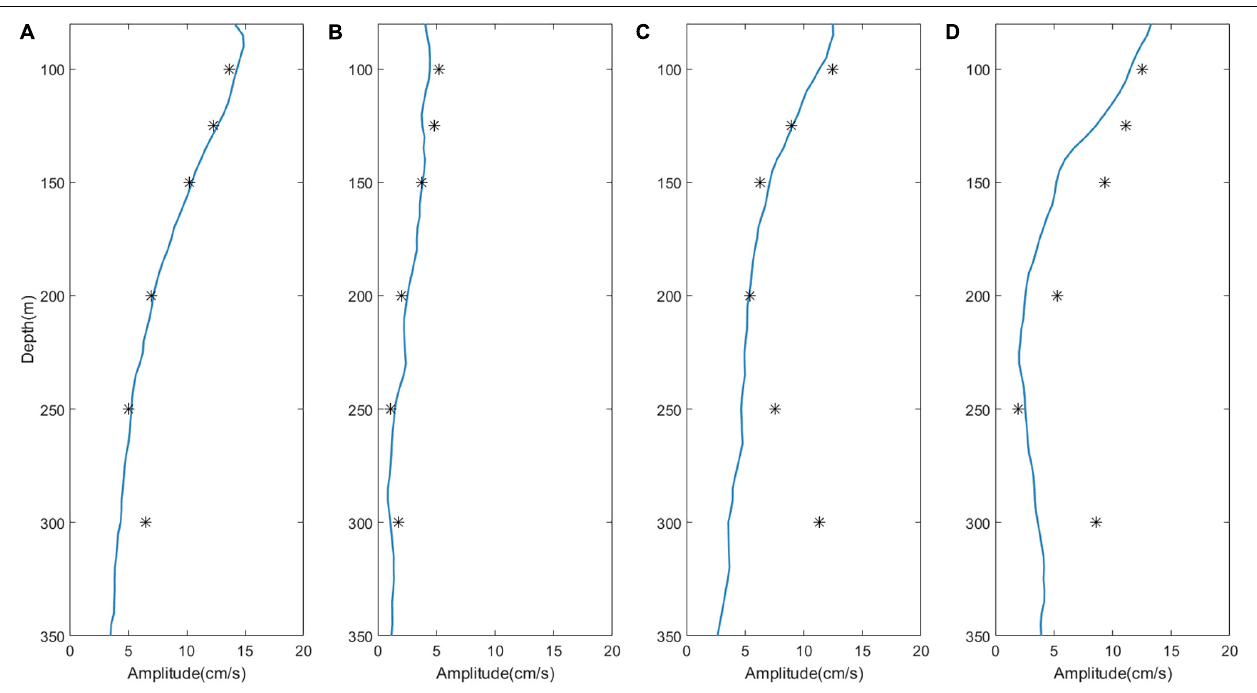
FIGURE 3 | Amplitudes of eastward baroclinic tidal currents of observation (blue line) and simulation (black asterisk) at frequency of (A) M 2 , (B) S 2 , (C) K 1 , and (D) O 1 .